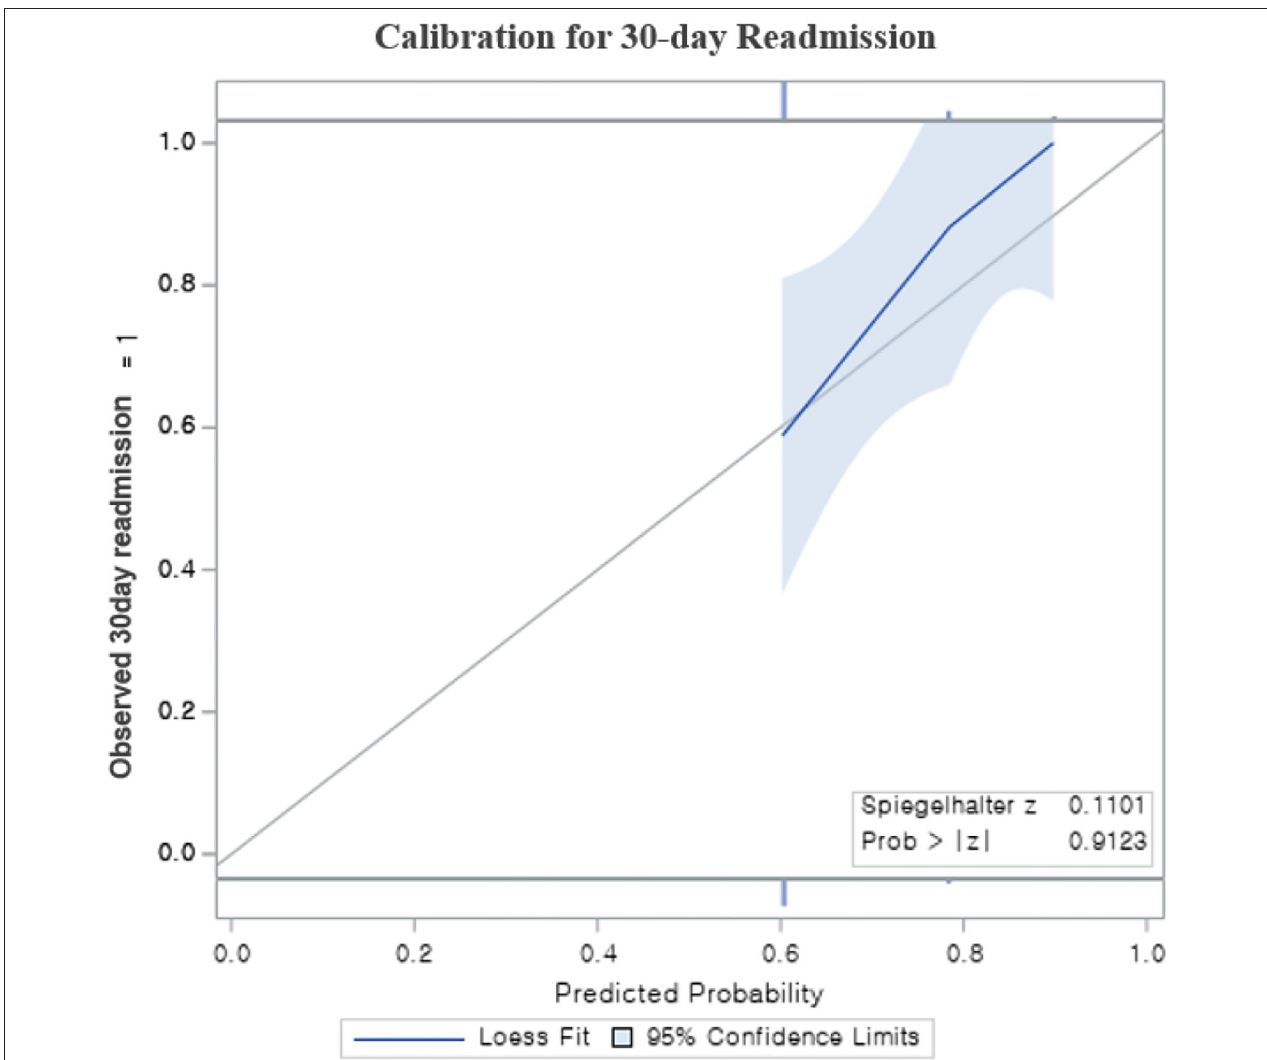
FIGURE 3 | The calibration plot for Risk prediction model for 30-day readmission; The plot contains a gray diagonal line, which represents perfect calibration. The light blue band is a 95% confidence, calibration plot of this fit also be close to the diagonal. Calibration plot, Hosmer–Lemeshow plot; p = 0.912.